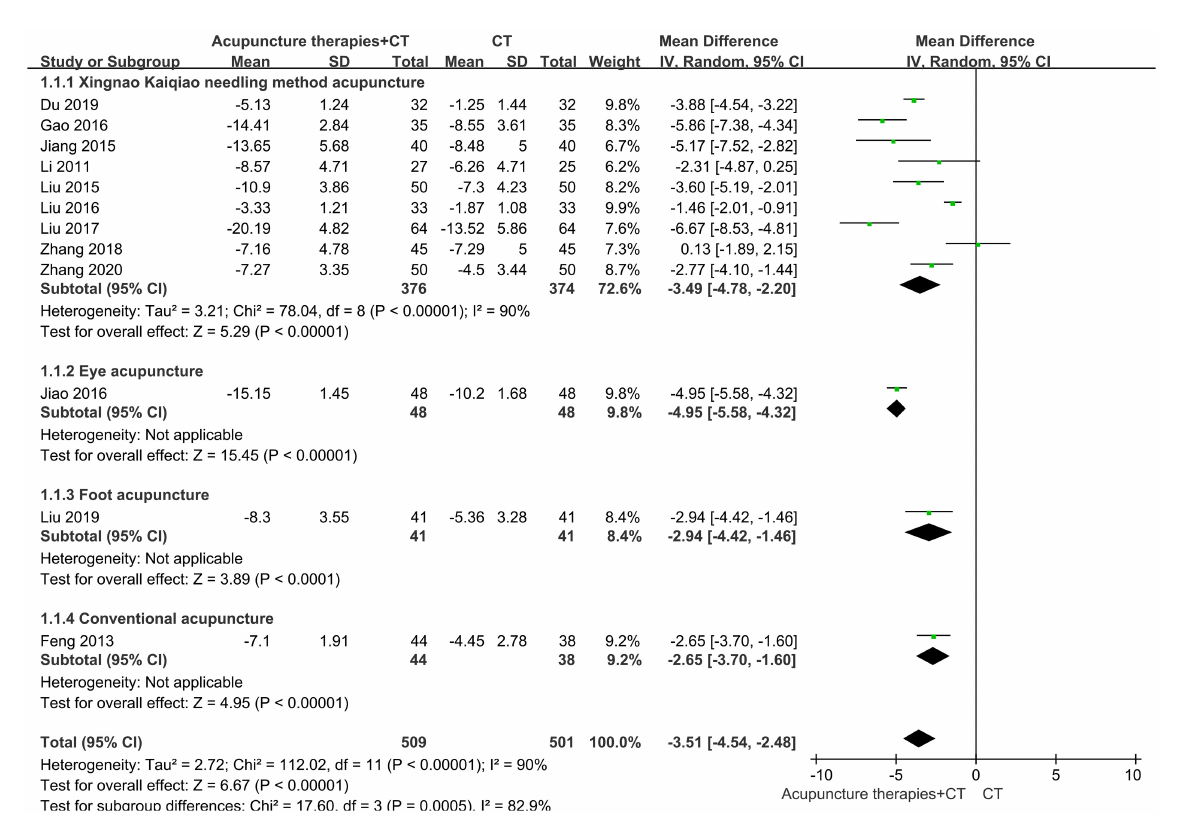
FIGURE4 Subgroup analysis of the NIHSS in patients receiving acupuncture therapies within 48h after AIS